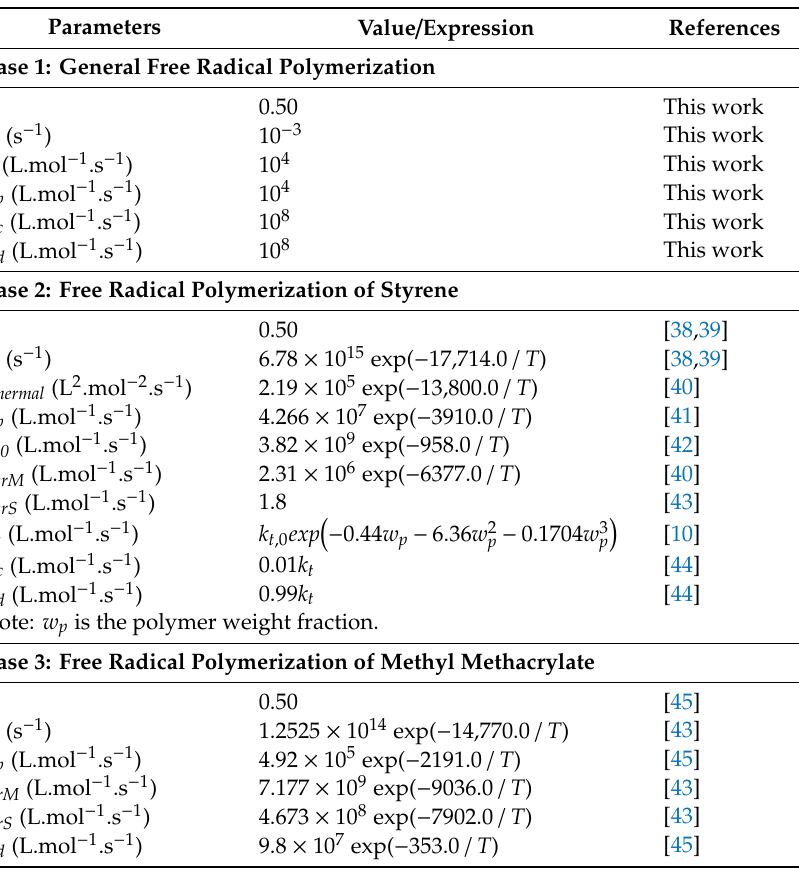
Table 2. Rate parameters used in the